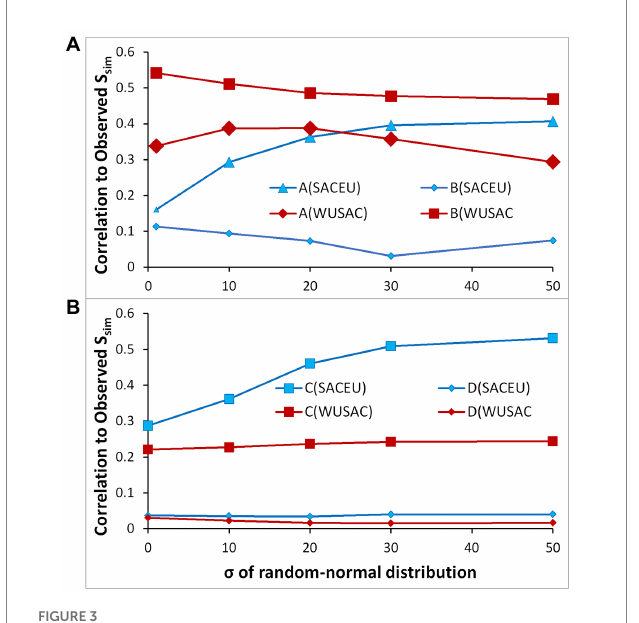
FIGURE 3 Correlations of simulated with observed similarities among all possible pairs of ranges in (A,B) SACEU (253) and WUSAC (1431) for designs A,B and C,D. The dispersal paramterCases with larger symbols have p < 0.01 and their 99% confidence intervals are within the size of the